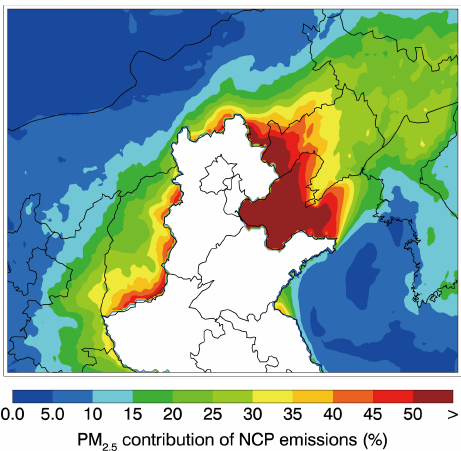
Figure 10. Average percentage contribution of NCP emissions to PM 2 . 5 concentrations in NEC and NWC from 22 to 28 May